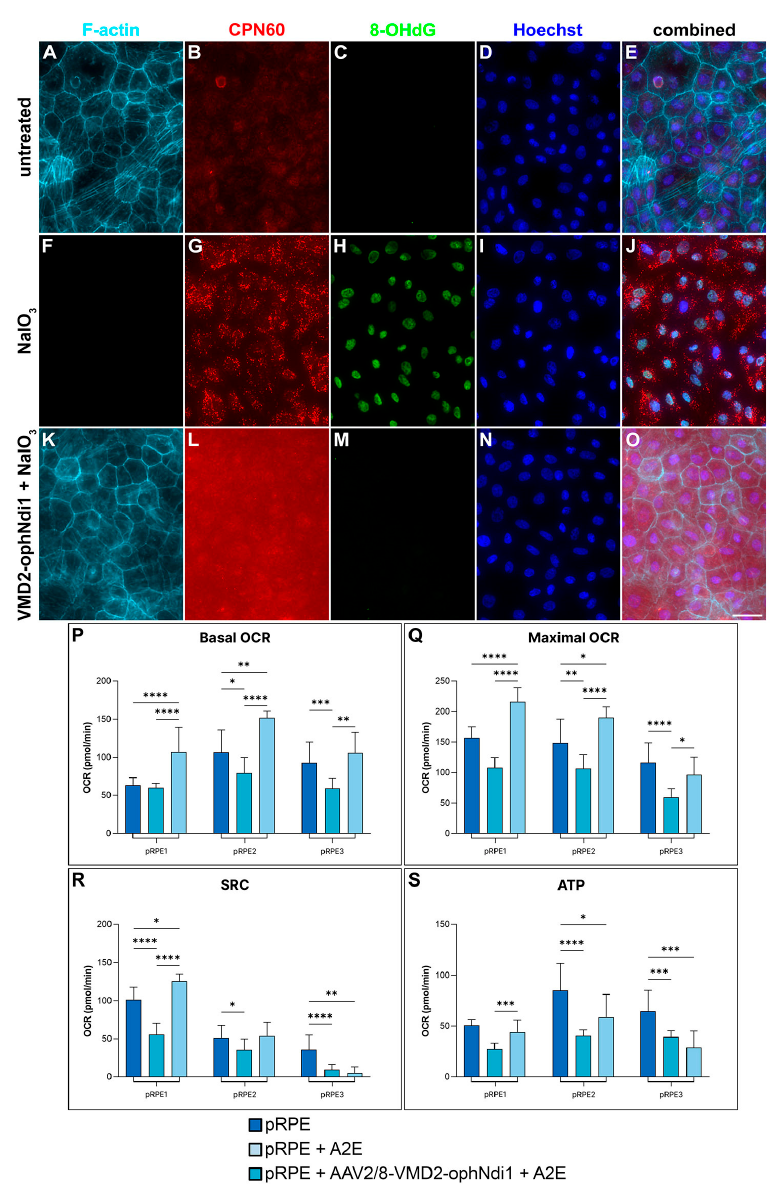
Figure 2. Rescue of primary pRPE cell models by AAV2/8-VMD2-ophNdi1. ( A – O ) Numbering 7.5 × 10 4, pRPE cells (from n = 3 pigs) were transduced with AAV2/8-VMD2-ophNdi1 5 h post-seeding (MOI = 3.4 × 10 6 ; K – O ). Cells were insulted 28 h post-transduction with 6 mM NaIO 3 ( F – O ) and 24 h post-insult cells were fixed and stained with Phalloidin-iFluor 647 (F-actin, light blue), CPN60 (mitochondrial marker, magenta) and 8-OHdG-Alexa Flour 488 (oxidative stress marker, green) im- munocytochemistries; nuclei were counterstained with Hoechst (nuclear stain, dark blue). AAV2/8- ophNdi-treated and NaIO 3 -insulted cells ( K – O ) were compared to untreated control cells ( A – E ) and to untreated cells insulted with NaIO 3 ( F – J ). ( P – S ) Numbering 5.0 × 10 4, primary pRPE cells ( n = 3 pigs; pRPE1-pRPE3) were seeded into XFe96 Seahorse plates. The following day, a minimum of five wells were transduced with AAV2/8-VMD2-ophNdi1 (MOI = 3.4 × 10 6 ). Transduced cells and un- transduced control cells ( n > 15 wells) were insulted 28 h post-transduction with 30 μ M A2E and exposed to 430nm blue light of ~1 mW/cm 2 for 3 h. ( P ) Basal and ( Q ) maximal oxygen consumption rates (OCRs), ( R ) spare respiratory capacity (SRC) and ( S ) ATP production were determined and are indicated. OCR was normalised to protein. Mitochondrial stress tests on pRPE1-3 were per- formed on 3 separate occasions * p < 0.05; ** p < 0.01; *** p < 0.001; **** p < 0.0001; ANOVA and post- hoc Tukey. Scale bar for immunocytochemistry panels ( O ) = 25 μ m.